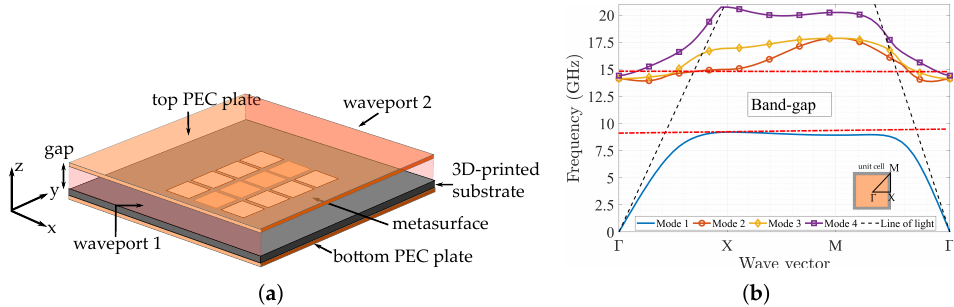
Figure 5. Metasurface inserted in a parallel plate waveguide. ( a ) Structure and components. ( b ) Dispersion diagram of the unit